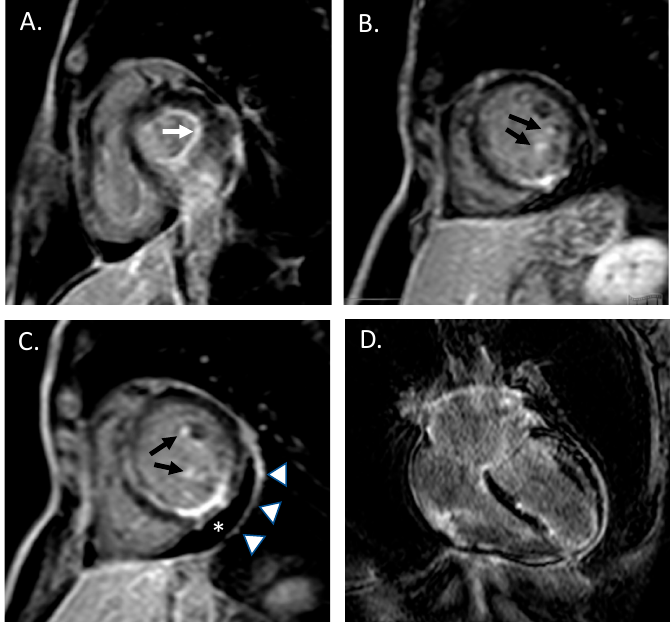
Figure 1. Cardiac MRI acquisitions obtained late after contrast injection, showing multiple areas of late gadolinium enhancement (LGE, “bright signal”) simultaneously affecting the endocardium, the myocardium and the pericardium. ( A ) short-axis view images documenting LGE involvement of mitral valve anulus (white arrow) and ( B , C ) left ventricular papillary muscles; ( C ) short-axis mid papillary view showing mild pericardial effusion (asterix) and pericardial enhancement; ( D ) four-chamber view image showing diffuse myocardial LGE involving left and right ventricles and both atria.